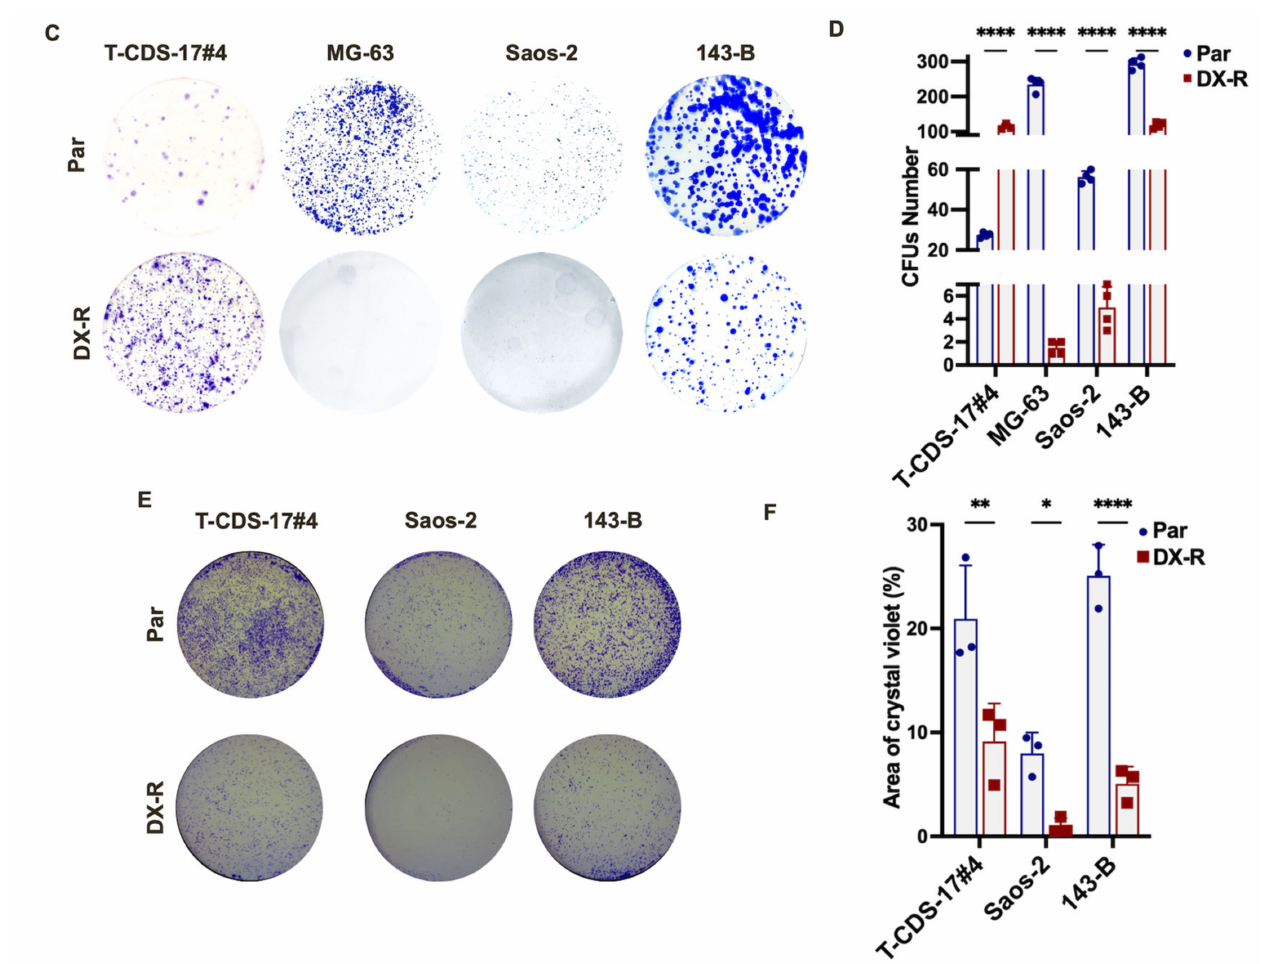
Figure 4. Proliferative and migration capability of DX-R bone sarcoma cell lines. ( A , B ) Real-time proliferation analysis (iCELLigence system) of the indicated parental and DX-R cells in the absence ( A ) or presence of IC 20 (8 nM for T-CDS-17#4, 6 nM for Saos-2 and 10 nM for 143-B), IC 50 (90 nM for T- CDS-17#4, 37 nM for Saos-2 and 50 nM for 143-B) or IC 90 (4600 nM for T-CDS-17#4, 633 nM for Saos-2 and 350 nM for 143-B) concentration of DOX ( B ). ( C , D ) Colony formation unit (CFU) assay of parental and DX-R bone sarcoma cell lines. Representative images ( C ) and quantification of the number of colonies obtained in each case ( D ) are shown. ( E , F ) Transwell migration assay of parental and DX-R bone sarcoma cell lines. Representative images ( E ) and quantification of the surface occupied by migrated cells ( F ) are shown. Data represent the mean and SD of three independent experiments. Asterisks indicate statistically significant differences between groups in one-way ANOVA test (ns: p > 0.05; *: p < 0.05; **: p < 0.01; ****: p <